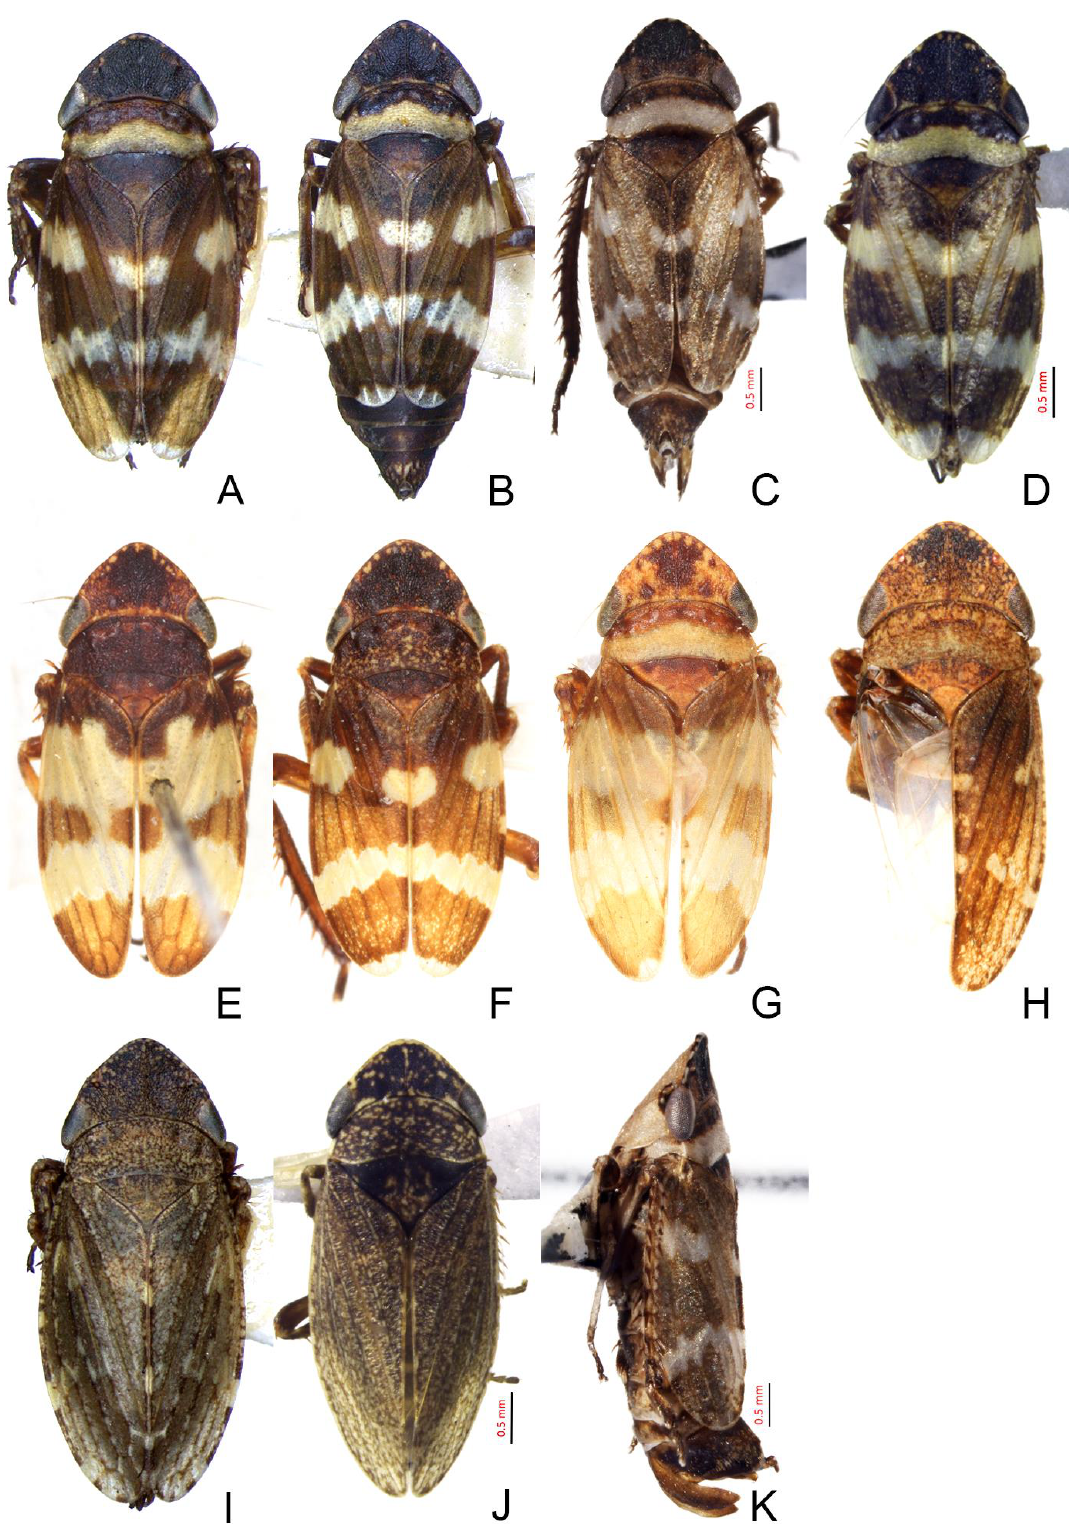
Figure 8. ( A – K ) Planaphrodes sahlbergi , dorsal and lateral habitus. ( A ) ♂ , Korea, Seolaksan GW. ( B ) ♂ ,